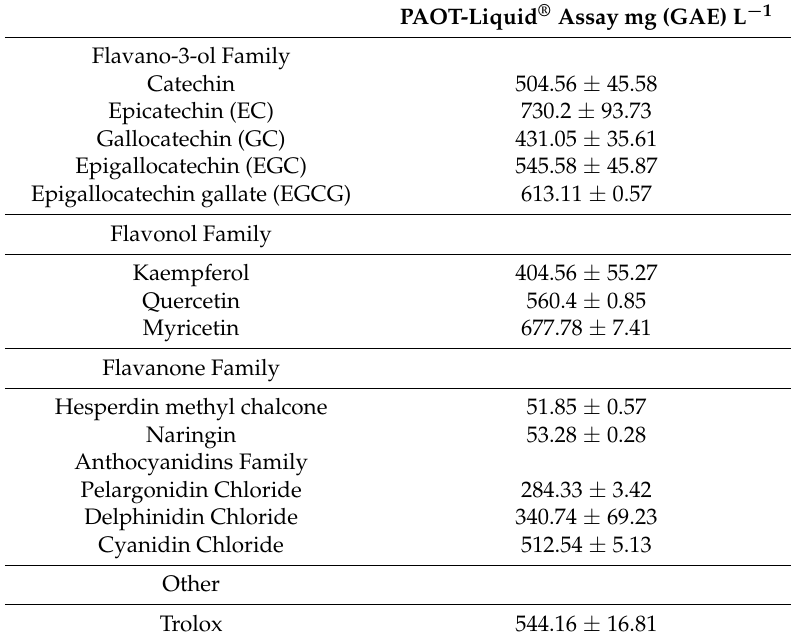
Table 2. PAOT-Liquid ® activity of several flavonoids, the major subclass of polyphenols family. Comparison with Trolox used as reference antioxidant in the DPPH